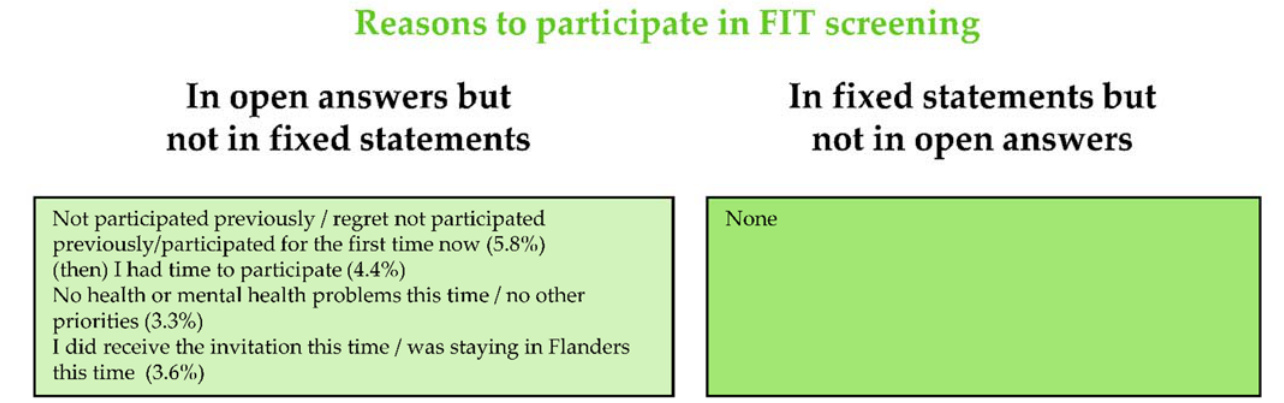
Figure 4. Reasons to participate in FIT screening among irregular participants in Flanders which are based on either the individuals’ self-reported open answers or given fixed statements (Q2 and S2) but not the other (only delayed entries N = 3401). Table 2. Results of survey statements about ‘the need for more information after the FIT invitation and the role of the GPs (S3)’ in absolute numbers and weighted